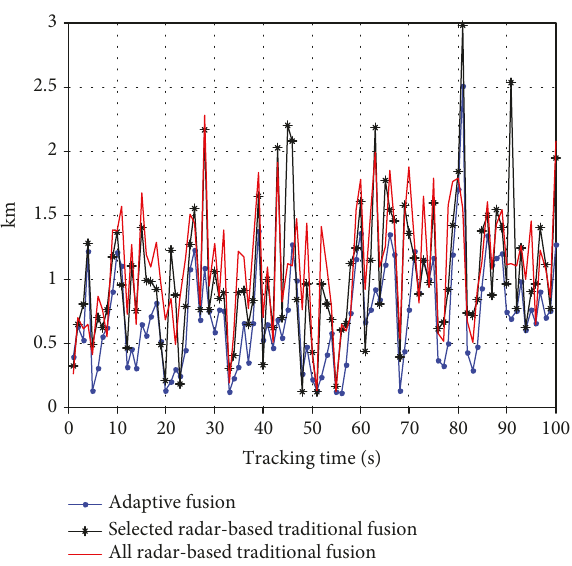
Figure 5: Range RMSE of Y